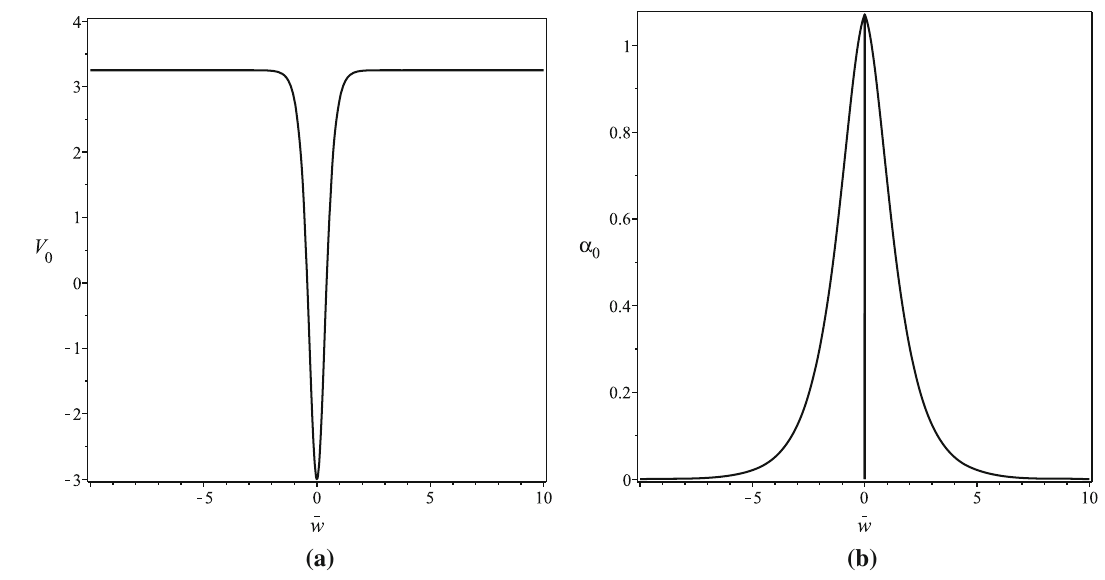
( a ) (b) Fig. 2 The profile of a the potential V 0 ( z ) and b the zero mode α 0 ( ¯ w) for b = 1, H = 1, η = 0 .